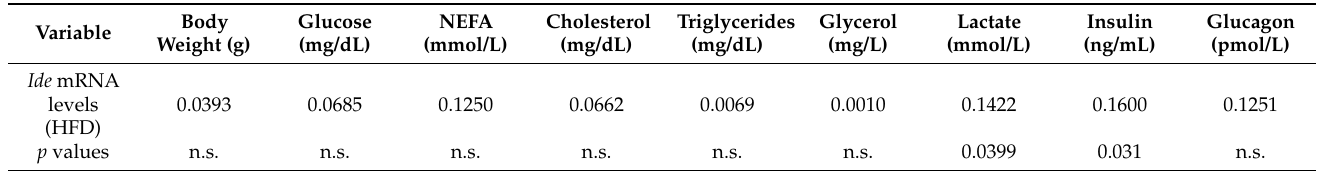
Table A2. R 2 values for hepatic IDE protein levels and metabolic parameters in mice fed an HFD. n.s., not statistically significant.